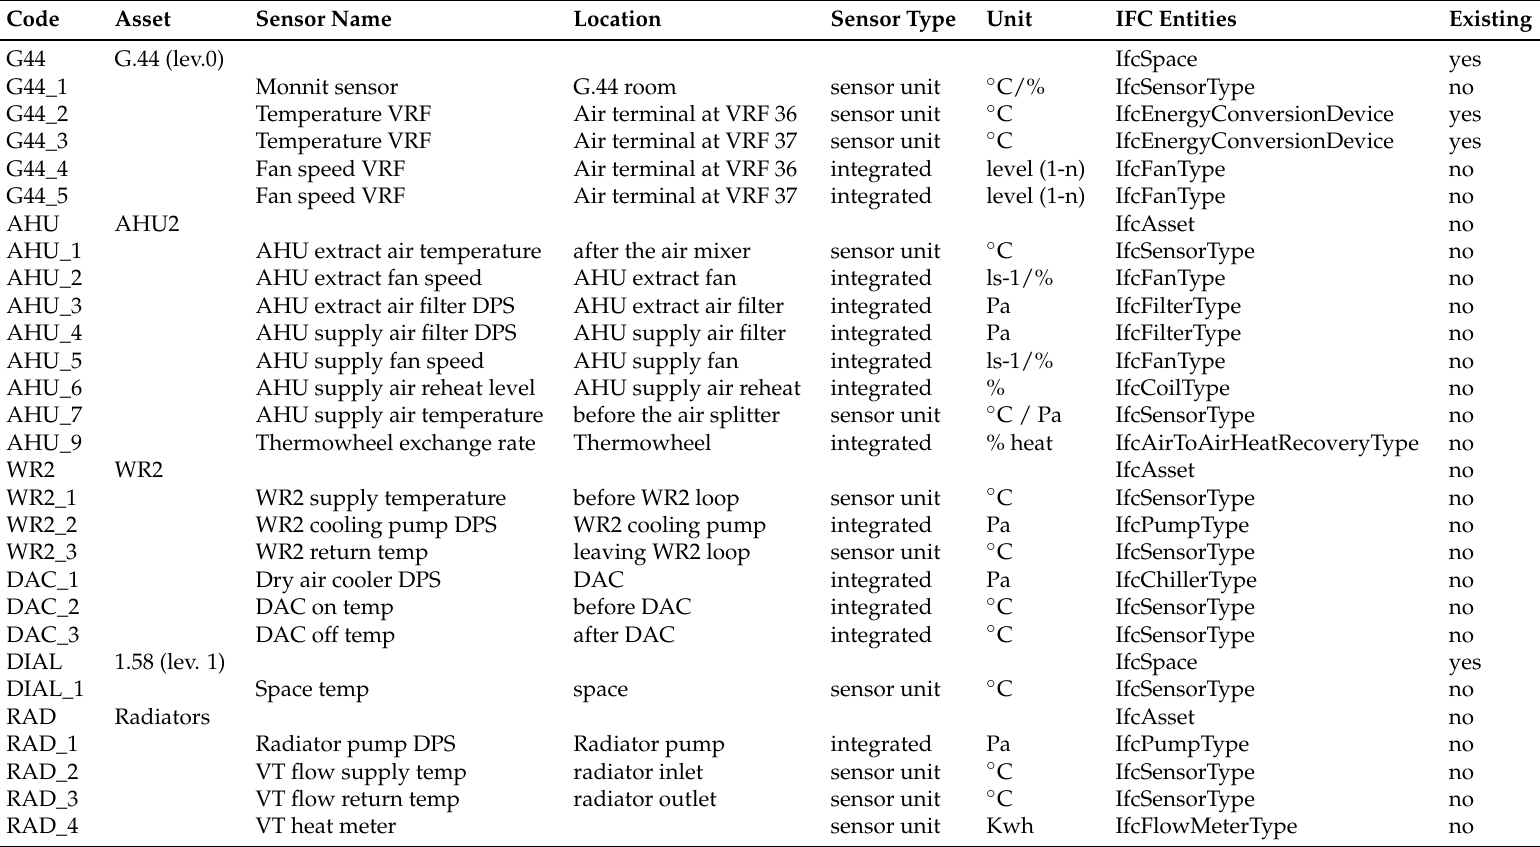
Table 2. Anomaly detection application information requirements